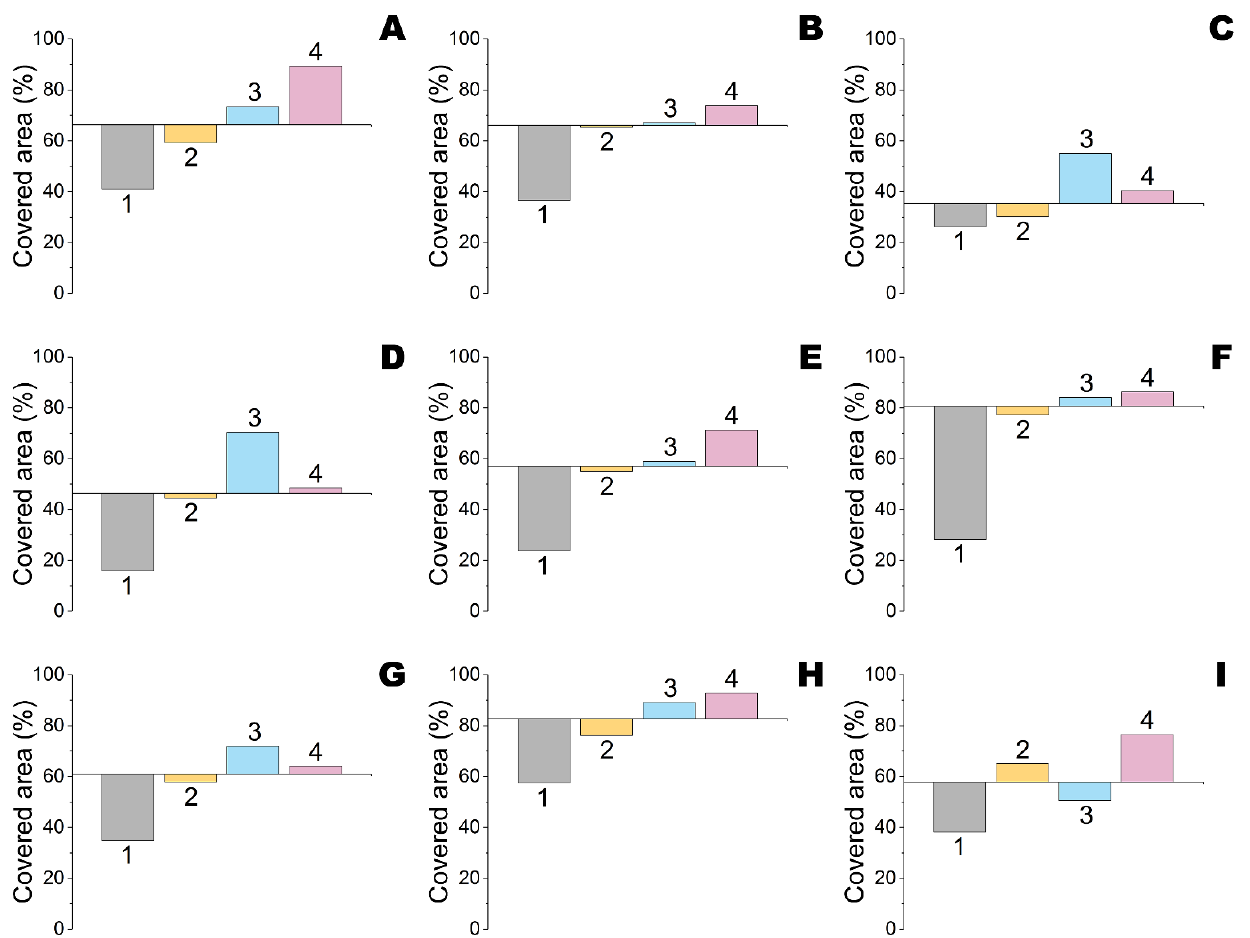
Figure 3. Relative surface near active sites of His 6 -OPH (#1), penicillin acylase (#2), carboxypeptidase A (#3) and thermolysin (#4) occupied by amentoflavone ( A ), apicidin ( B ), DIPT ( C ), emodin ( D ), naringenin ( E ), ngercheumicin A ( F ), savirin ( G ), UP5 ( H ) and amirinic acid ( I ) at pH 7.5. An interception of x -axis is equal to a median value for all four enzymes interacting with the certain effector under consideration.